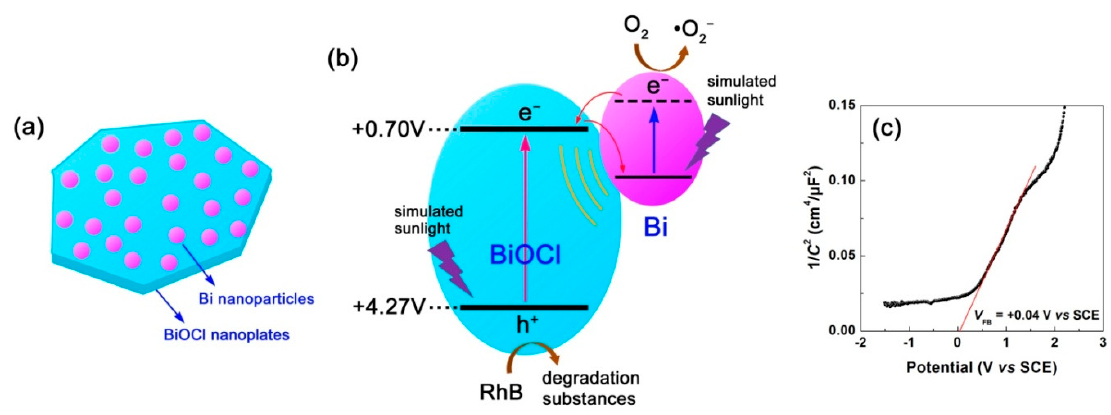
Figure 14. ( a ) Schematic illustration of the Bi@BiOCl hybrid composites with Bi nanoparticles assembled on the surface of BiOCl nanoplates. ( b ) Schematic illustration of the photodegradation mechanism of the Bi@BiOCl hybrid composites. ( c ) Mott–Schottky plot of BiOCl nanoplates.